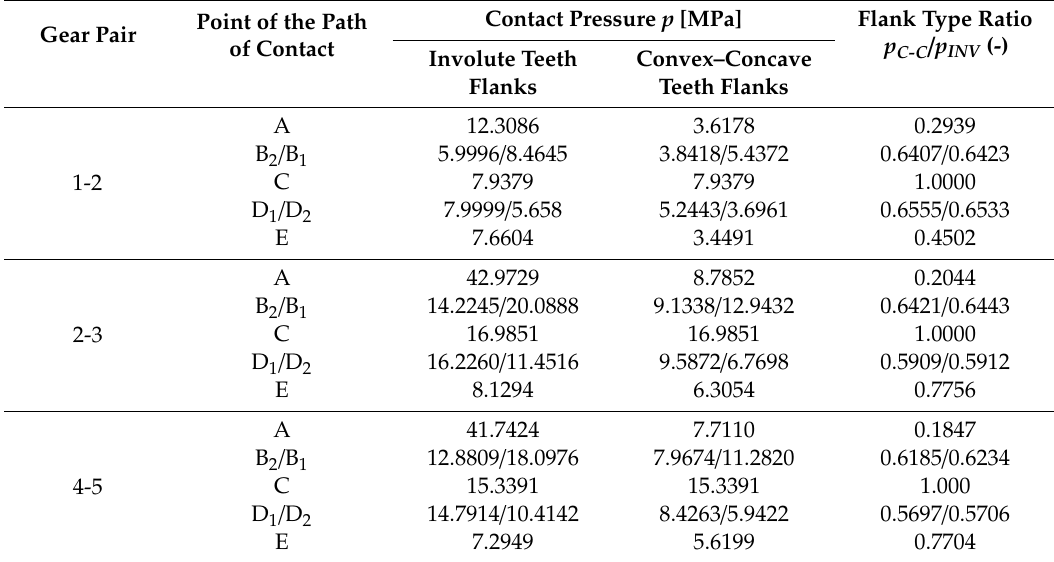
Table 3. Contact pressures of the partial gear pairs of the calculated gearbox. Gear Pair